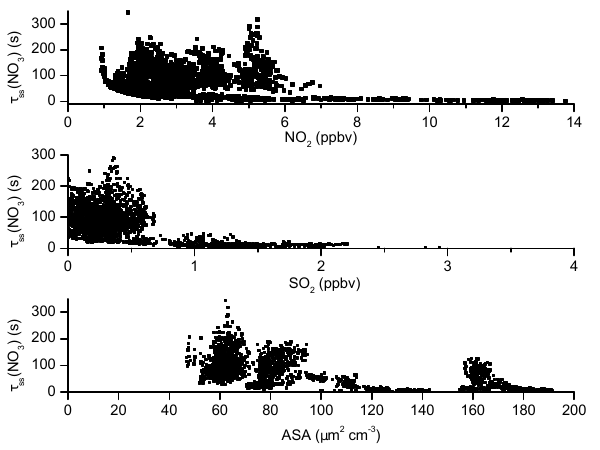
Fig. 9. Apportioned NO 3 loss rates on the night 23–24 November. The various contributions are: Rwater=homogeneous hydrolysis of N 2 O 5 with water vapour, RN 2 O 5 ASA=uptake of N 2 O 5 to aerosol, RNO=reaction of NO 3 with NO, Rbiogen=reaction of NO 3 with isoprene, limonene and α -pinene, Rdd=summed dry deposition of N 2 O 5 and NO 3 , RNO 3 ASA=reaction of NO 3 on aerosol, RSO 2 is the missing reactivity which has been scaled to correlate with SO 2 mixing ratios. The black dots datapoints are the calculated loss frequency of NO 3